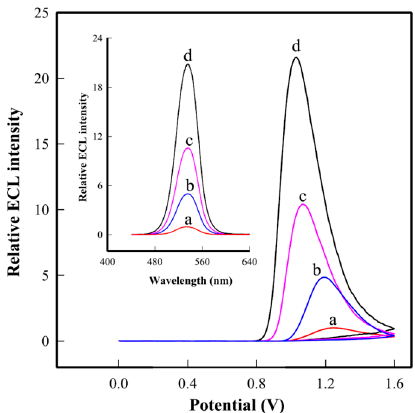
Figure 7. Anodic ECL profiles of FAPbBr 3 NC/GCE (a), TiO 2 NPs@FAPbBr 3 NC/GCE (b), FAPbBr 3 NC@CNT/GCE (c), and TiO 2 NP@FAPbBr 3 NC@CNTs/GCE (d) in pH 7.4 PBS containing 0.2 M KCl and 15 mM TPrA. Inset: oxidative-reduction ECL emission spectra. Reproduced with permission from Ref. [58]. © Elsevier.